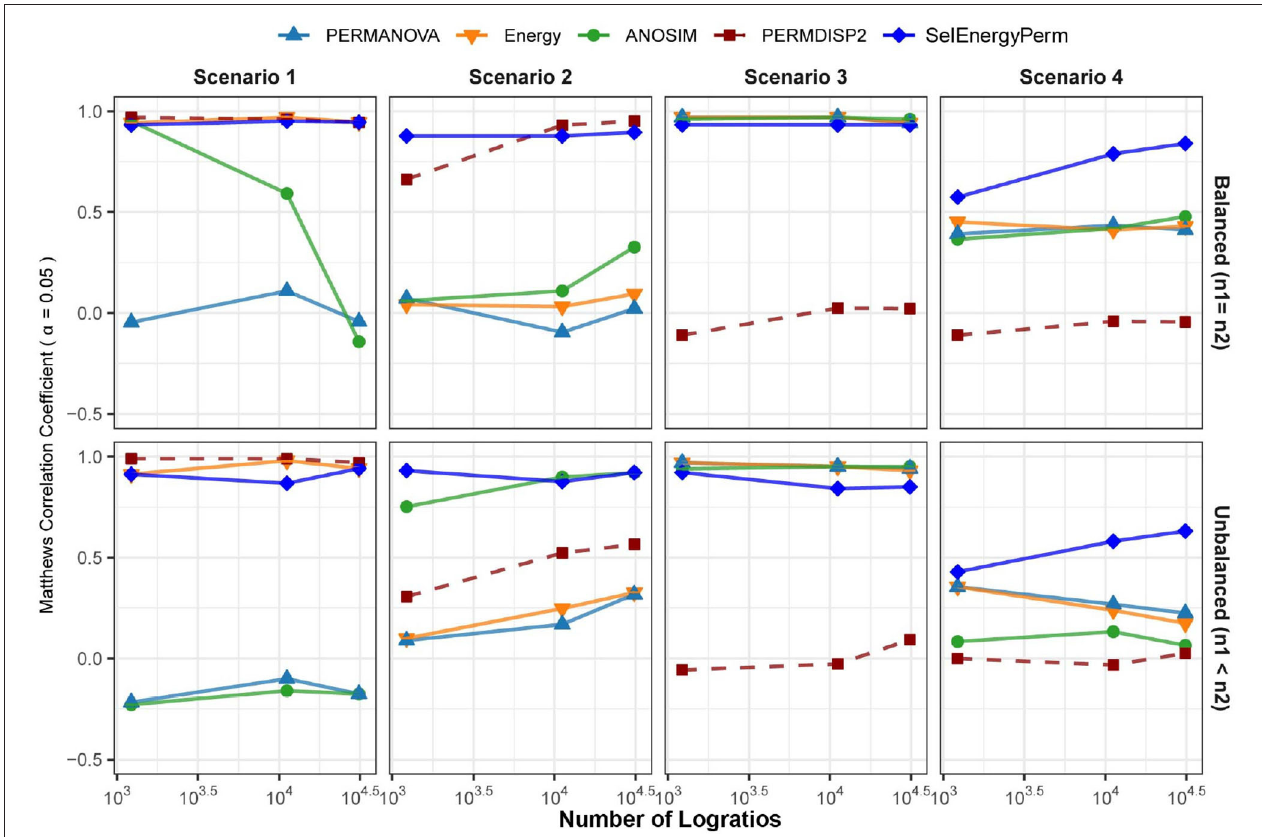
FIGURE 3 | Comparison of the Matthews Correlation Coefficient measuring the ability of each method to properly detect/reject associations in data generated from synthetic distributions in both balanced and unbalanced sampling designs. For each scenario and logratio feature space size, test datasets were simulated to include data distributions that have either true between-group differences ( n 100) or no between-group difference ( n 100). Results from the PERMDISP2 procedure are = = displayed to indicate heterogeneity of variance between